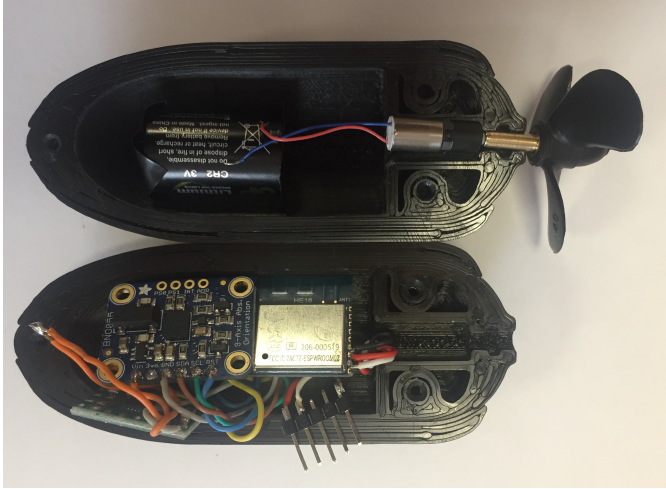
Figure 3. Incorporated electronics inside the